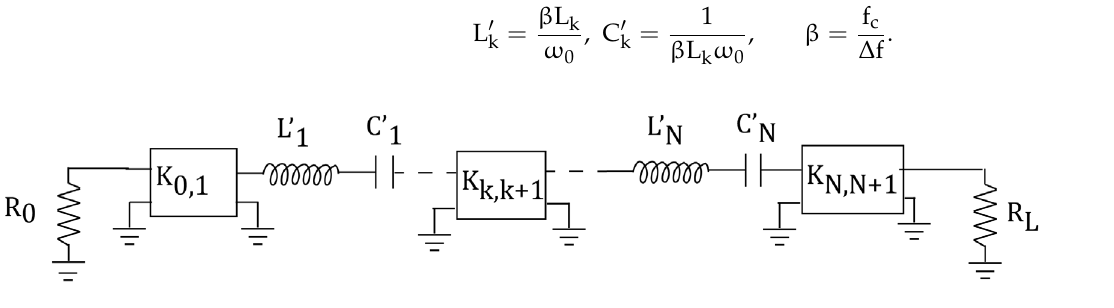
Table 1. Chebyshev coefficients of a 4th-order filter for a 0.01 dB ripple. n